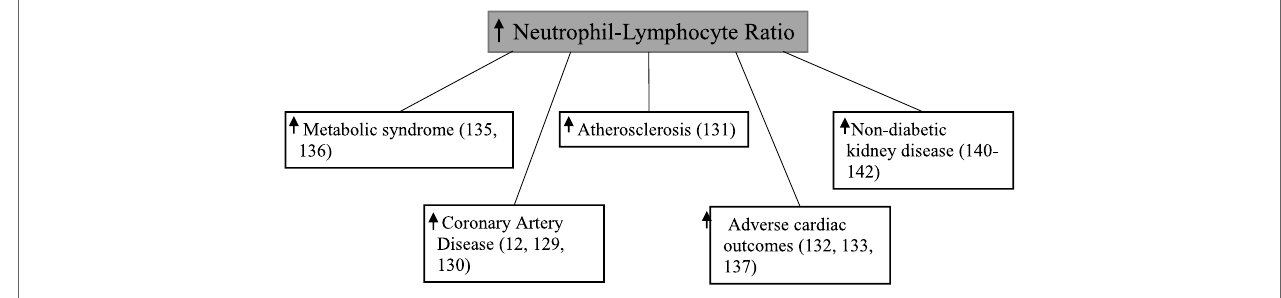
FiGURe 5 | Elevated neutrophil–lymphocyte ratio and various disease